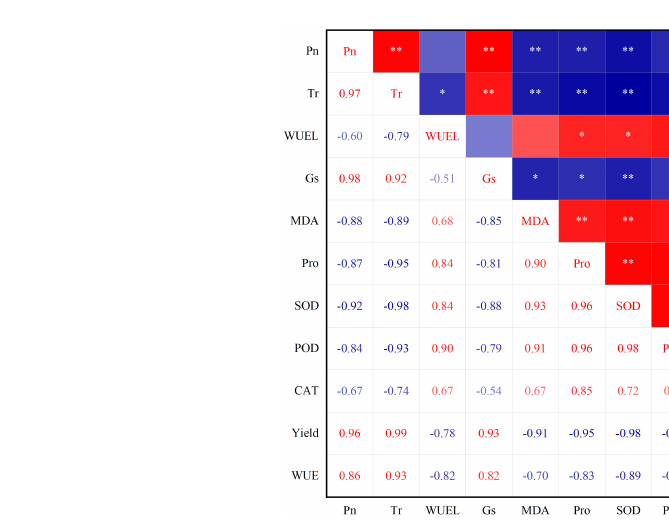
FIGURE 10 The correlations among Pn, Tr, WUEL, Gs, MDA, Pro, SOD, POD, CAT, yield, and WUE. The numbers in the squares are the correlation coef fi cients. Pn, the net photosynthetic rate; Tr, transpiration rate; WUEL, the water use ef fi ciency of woad leaves; Gs, stomatal conductance; MDA, malondialdehyde; Pro, proline; SOD, superoxide dismutase; POD, peroxidase; CAT, catalase; WUE: water use ef fi